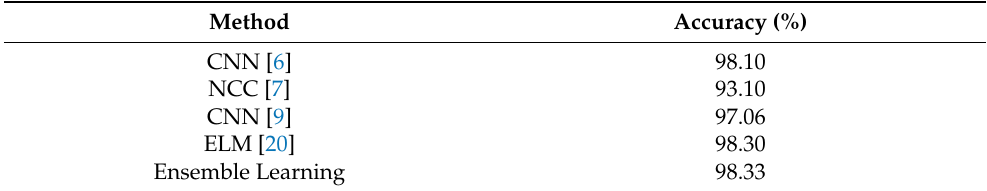
Table 13. Comparative results on BTSD dataset.